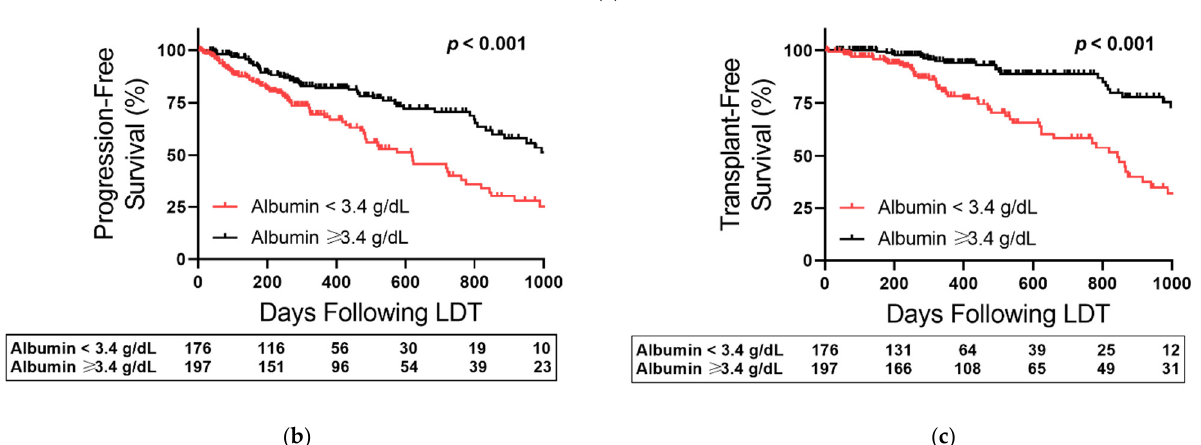
Figure 3. Albumin-Stratified Kaplan–Meier Curves of Bridge to Transplant Outcomes after First Cycle Liver-Directed Therapy (LDT). ( a ) Percentage of patients without hepatocellular carcinoma progression as a function of time and stratified at an albumin level of 3.4 g/dL. ( b ) Progression-free survival curves stratified by albumin level. ( c ) Transplant-free survival curves stratified by albumin level. Censored data is marked with a vertical upward dash. The total number of patients remaining in the analysis at each major x-axis time point is listed in the table below the plot. Significance was determined using the Log-Rank test.